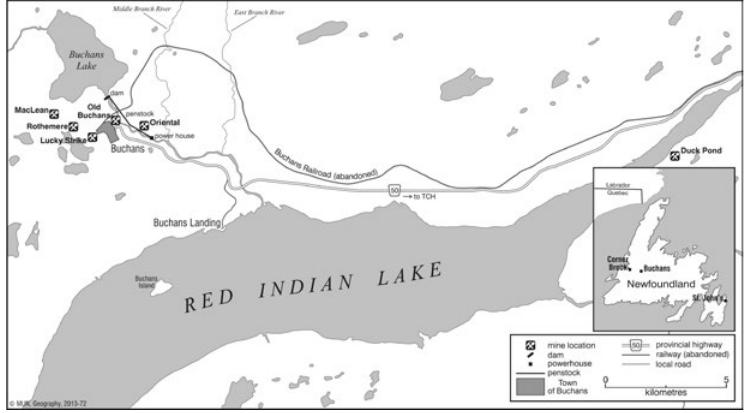
Figure 1. Locations of community and mine sites and inset showing town of Buchans in relation to NL cities. Map courtesy of Charlie Conway,